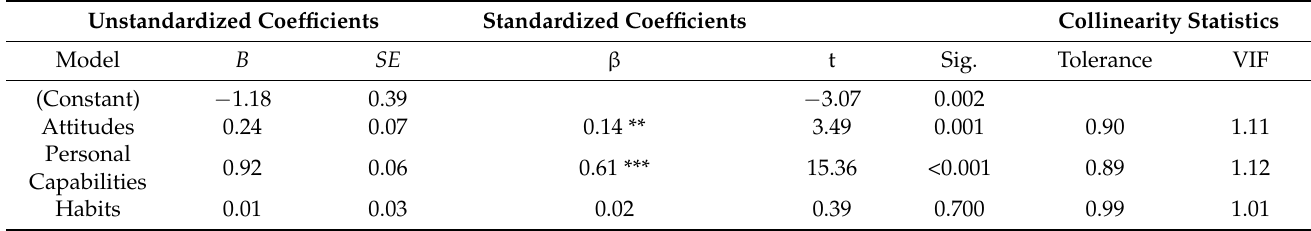
Table 5. Effects of Attitudes, Personal Capabilities, and Habits on Intention.